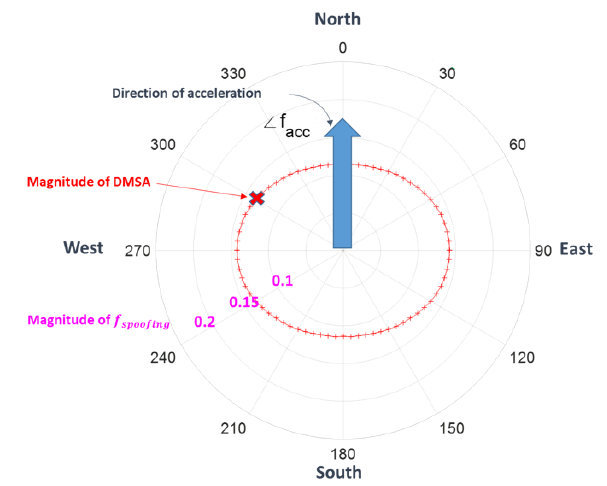
Figure 10. Detectable minimum spoofing acceleration (DMSA), the angle denotes the direction of 𝒇 𝒔 , i.e., ∠ 𝒇 𝒔 . Sensors 2020 , 20 , 954 16 of 22